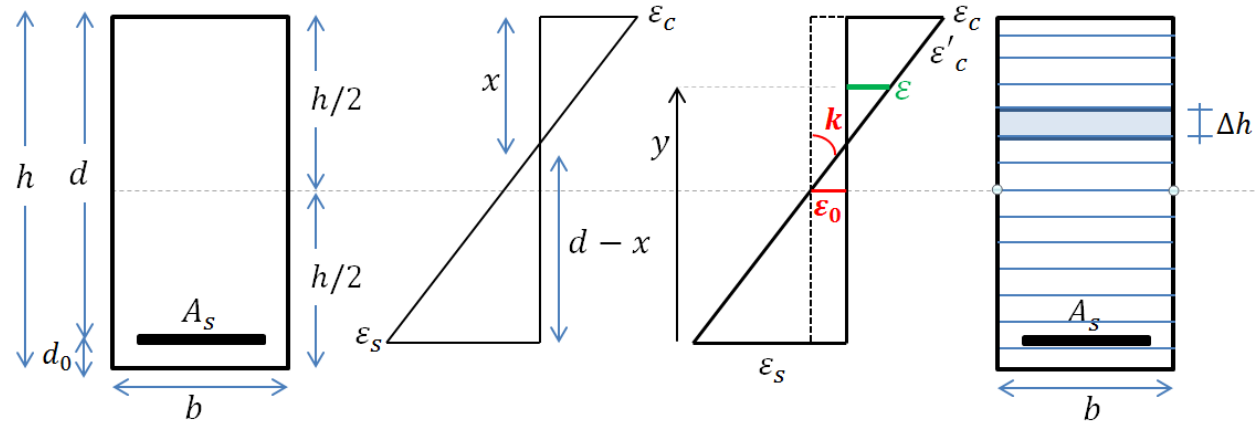
Figure 4. RC section with Strain distribution diagram & dividing the section into layers. Any fiber’s deformation in the cross section may be defined as a function of the curvature, κ , and mean normal strain so-called ε 0 at the beam axis. Equation (8) can be used to calculate the strain in the strip that is positioned at y distances from the beam’s